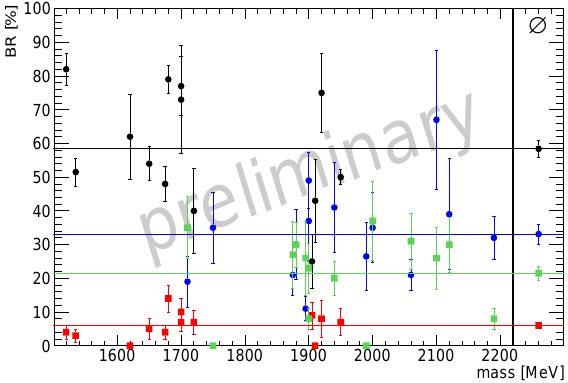
Figure 7. Branching ratios of resonances included in the BnGa- PWA are illustrated. One-oscillator resonances decaying into the ground states (N π or Δ π ) are shown as black dots, decays into ex- cited resonances (N(1520) π , N(1535) π , N(1680) π , or N σ ) as red squares. Mixed-oscillator states decaying into the ground states are shown as blue dots, those decaying into the excited states as green squares. Additionally, the average branching ratios are shown on the right and as colored